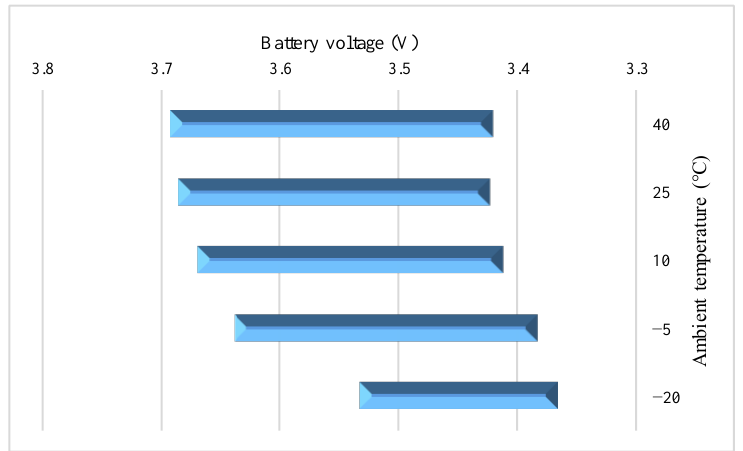
Figure 8. The voltage variation interval diagram of the voltage plateau period during 0.1C dis- charge.